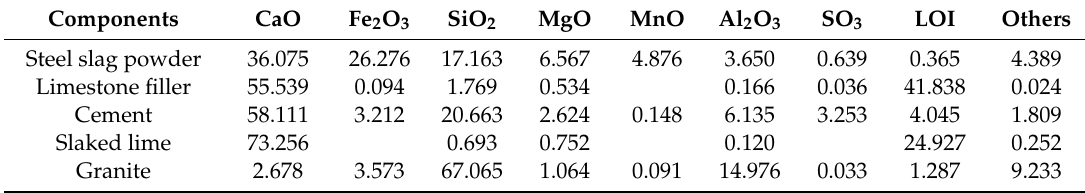
Table 4. Chemical compositions of the four fillers and granite Table 3. Chemical compositions of the four fillers and granite aggregate.